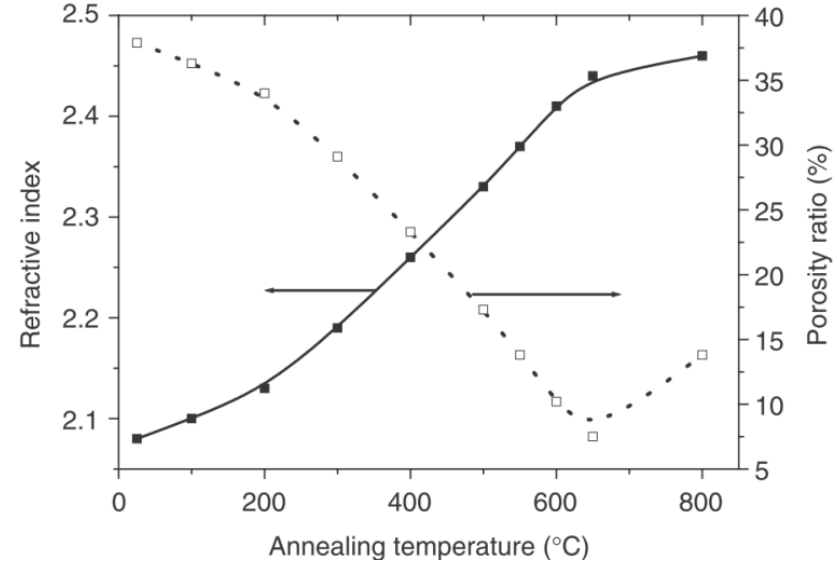
Figure 16. Dependence of refractive index and porosity of TiO 2 films on annealing temperature. Reprinted with permission from [71], copyright 2007, Elsevier.